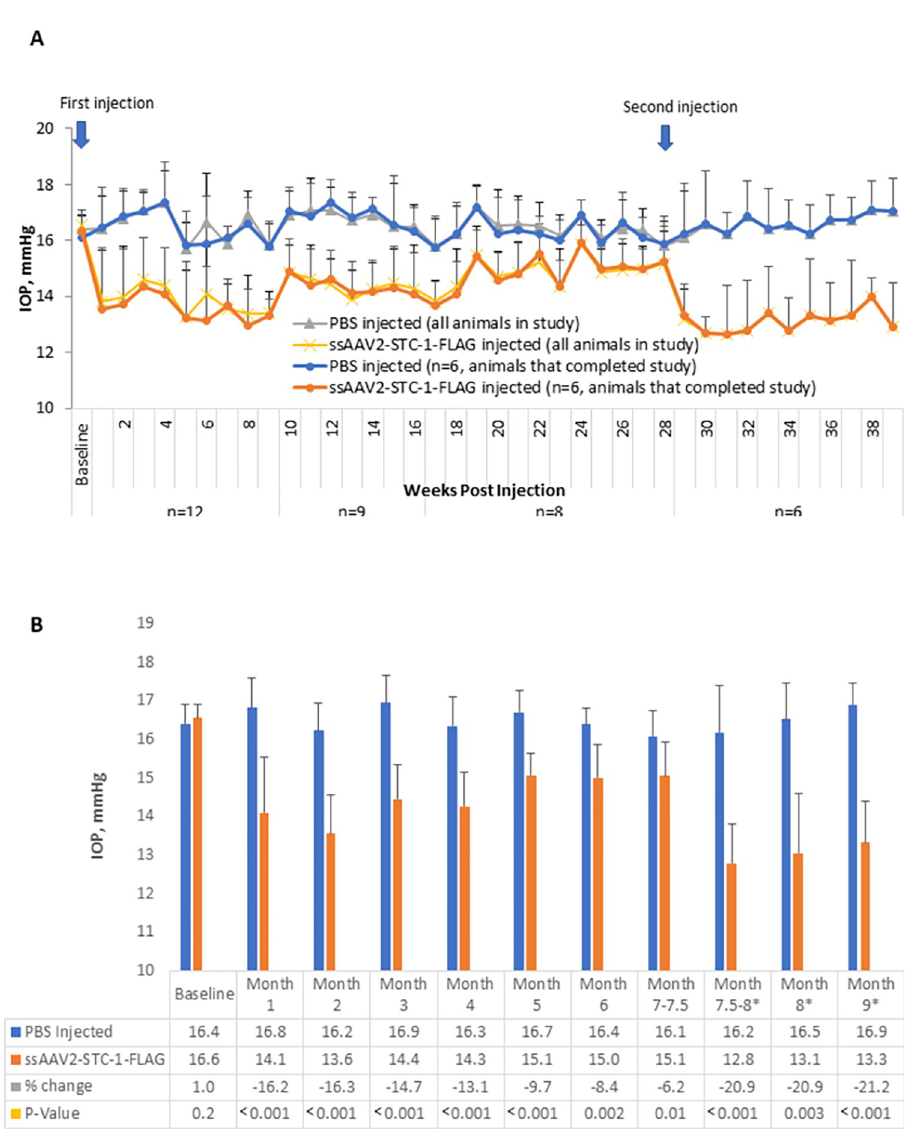
Fig 3. ssAAV2-STC-1-FLAG reduces IOP in a sustained fashion. A) After baseline IOP measurements, ssAAV2-STC-1-FLAG was injected in one eye and PBS was injected into the fellow eye of 3-month-old C57BL/6J mice (n = 12, 1 μ L, intracameral injection, 3x10 9 VGs). At the end of experimental week 28, all remaining mice in the study (n = 6) received a second injection. IOP reduction was observed by week one post-injection and this persisted through the end of the experimental period. As IOP lowering began to wane, this was rescued with a repeat injection at week 28. Animals that completed the study were separately designated to demonstrate representative samples. B) Similar data presented in a bar graph format with statistical analysis performed on the average monthly values. � Data where mice had received a second injection. month 7 (single injection) showed that following the second injection of AAV-STC-1-FLAG, eyes had a significantly lower IOP (13.1 ± 1.5 vs. 15.1 ± 0.9 mmHg, P < 0.05). To determine whether the initial IOP lowering was superior following two injections compared to one injec- tion, month 8 ssAAV-STC-1-FLAG twice-injected eyes were compared to once-injected ssAAV2-STC-1-FLAG eyes at month 1 and no significant difference was seen (13.1 ± 1.5 vs 14.1 ± 1.4 mmHg, P = 0.5). Fig 4A contains a separate line graph showing the six re-injected animals are a representative sample of the original cohort.